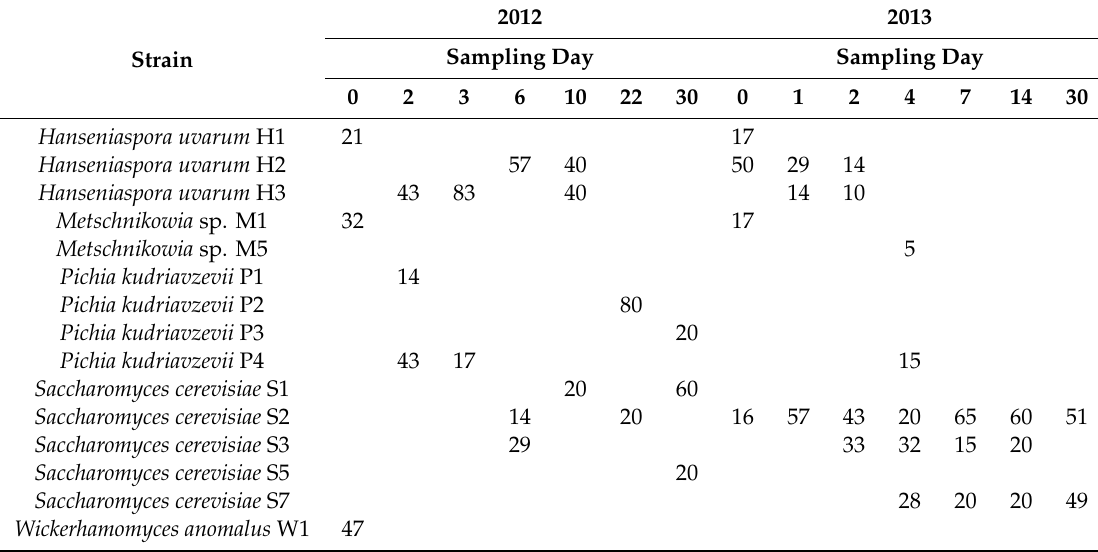
Table 2. Yeast strains (%) isolated from di ff erent stages of W˛egierka Zwykła plum mash fermentation (2012 and 2013 seasons).